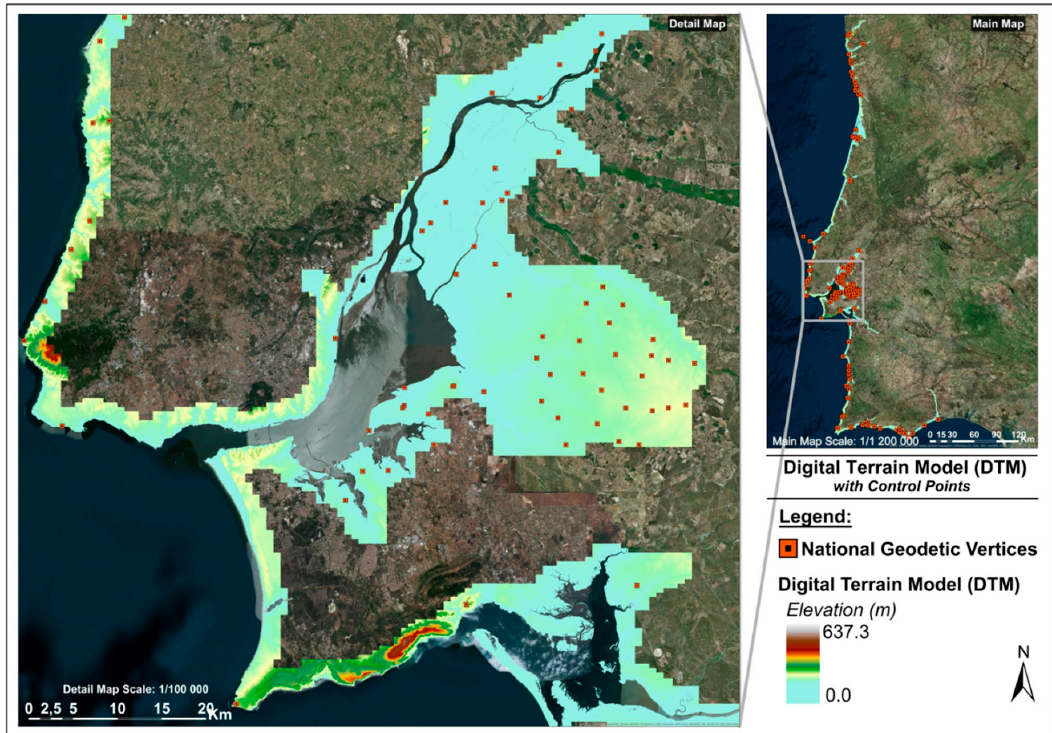
Figure 4. Digital Terrain Model of the Atlantic Coast of Portugal’s mainland, with a spatial resolution of 20 m and 56 cm of relative accuracy estimated using the National Geodetic Network.